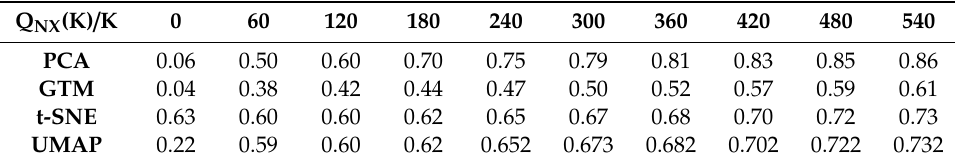
Table 2. Visualization quantification index (Q NX ) for DRTs against neighborhood sizes